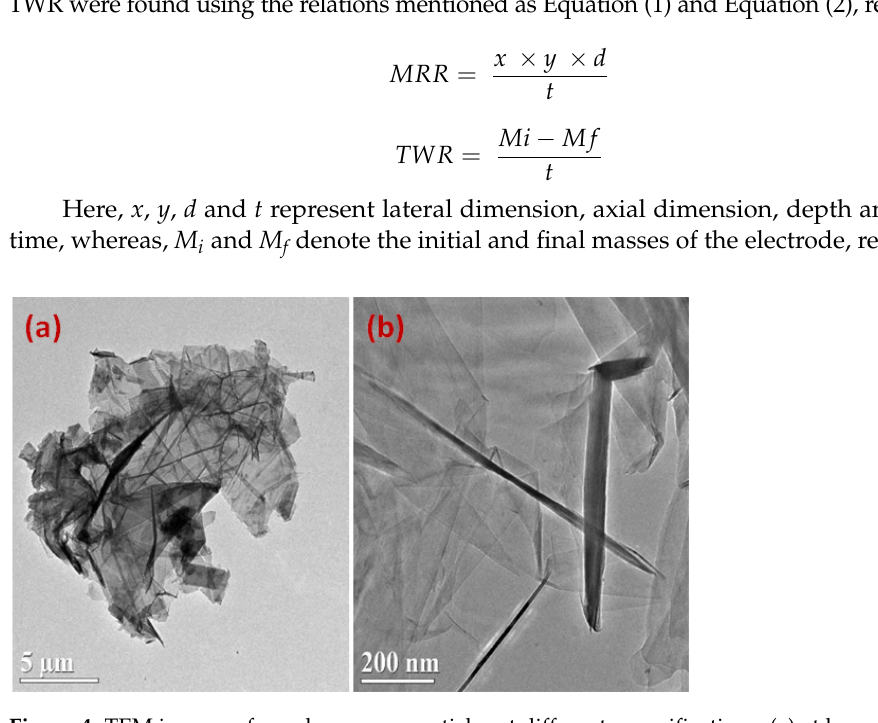
Figure 4. TEM images of graphene nanoparticles at different magnifications; ( a ) at lower magnification, and ( b ) at higher magnification [45].